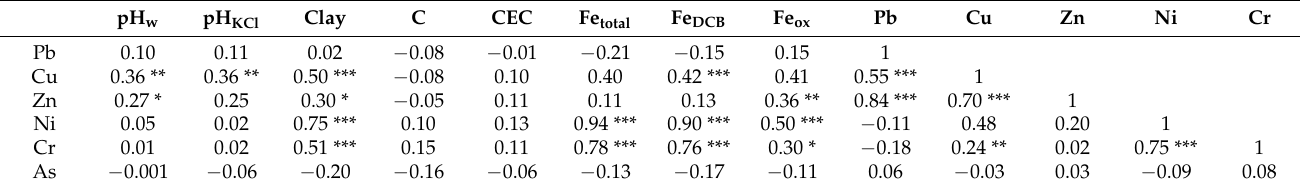
Figure 2. Soil trace element concentrations split by lithology of the parent material. Different letters mean statistically significant differences between lithologies in the Tukey test at p < 0.05. Table 4. Correlations between trace element concentrations and edaphic properties. Significance of correlation is indicated as follows: * significant at a p -value of 0.05; ** significant at a p -value of 0.01; *** significant at a p -value of